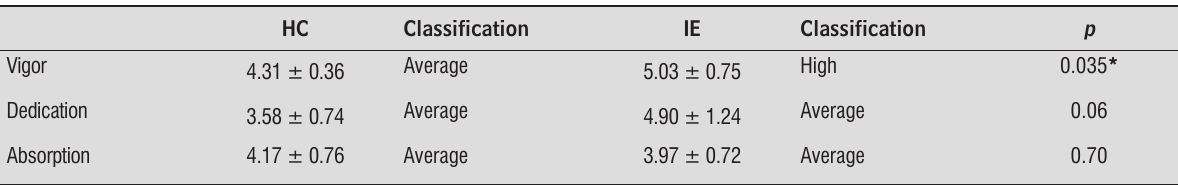
Table 1 - Mean scores (and respective nominal classifications) from work engagement (UWES) for Health Clinics (HC) and Institution for the Elderly (IE) (mean ± standard deviation)